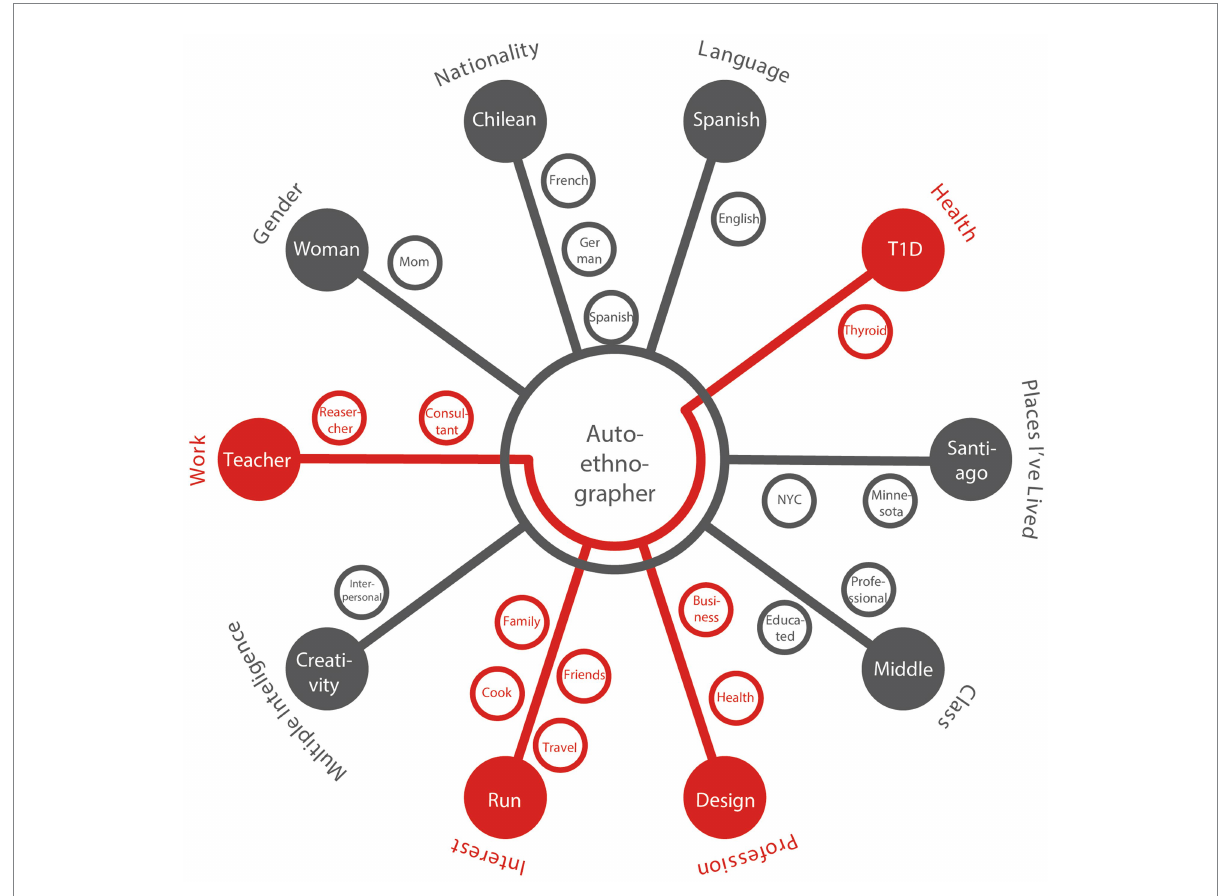
FIGURE 2 Identity map visualizing self-identifiers and social